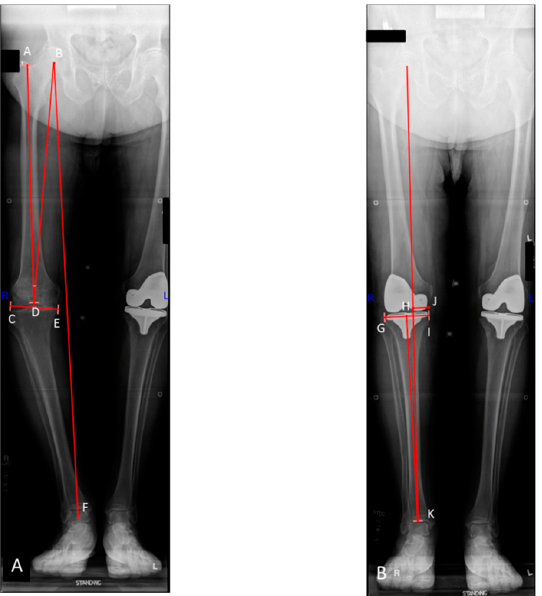
Figure 1. Preoperative ( A ) and post-operative ( B ) standing hip–knee–ankle radiographs following primary total knee arthroplasty (TKA) of patient in the outlier group. Line B–F represents the mechanical axis of the limb. The angle formed by lines A–D and C–E represents the mechanical axis of the femur. Angle A–D–B represents the femoral mechanical axis (FMA) angle. The angle formed by lines H–K and G–I represents the mechanical axis of the tibia. The distance from point J to the mechanical axis of the limb represents the post-operative mechanical width.